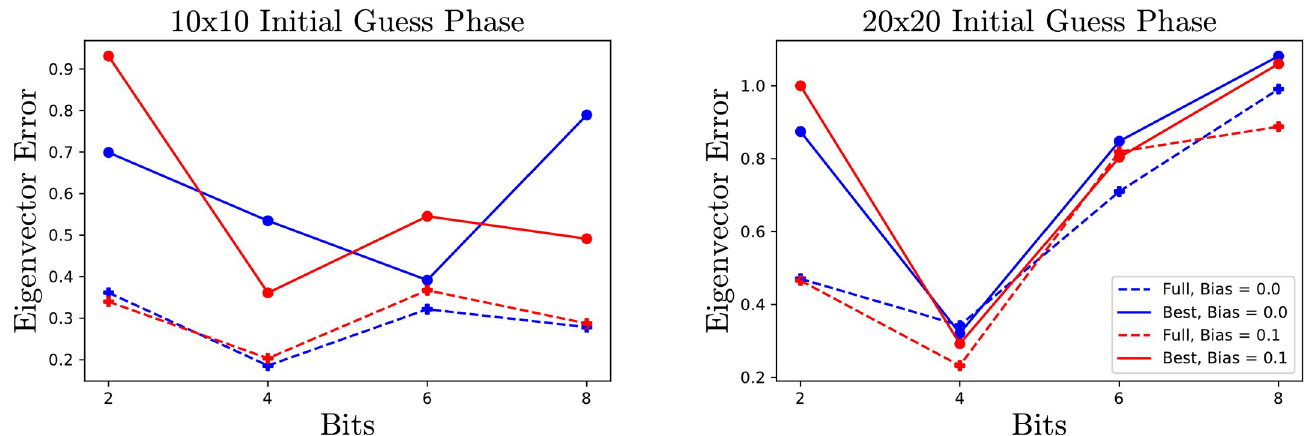
Fig 4. Eigenvector error for MP matrices at the end of initial guess phase. Observe that for small QUBOs the full response decreases the error significantly.